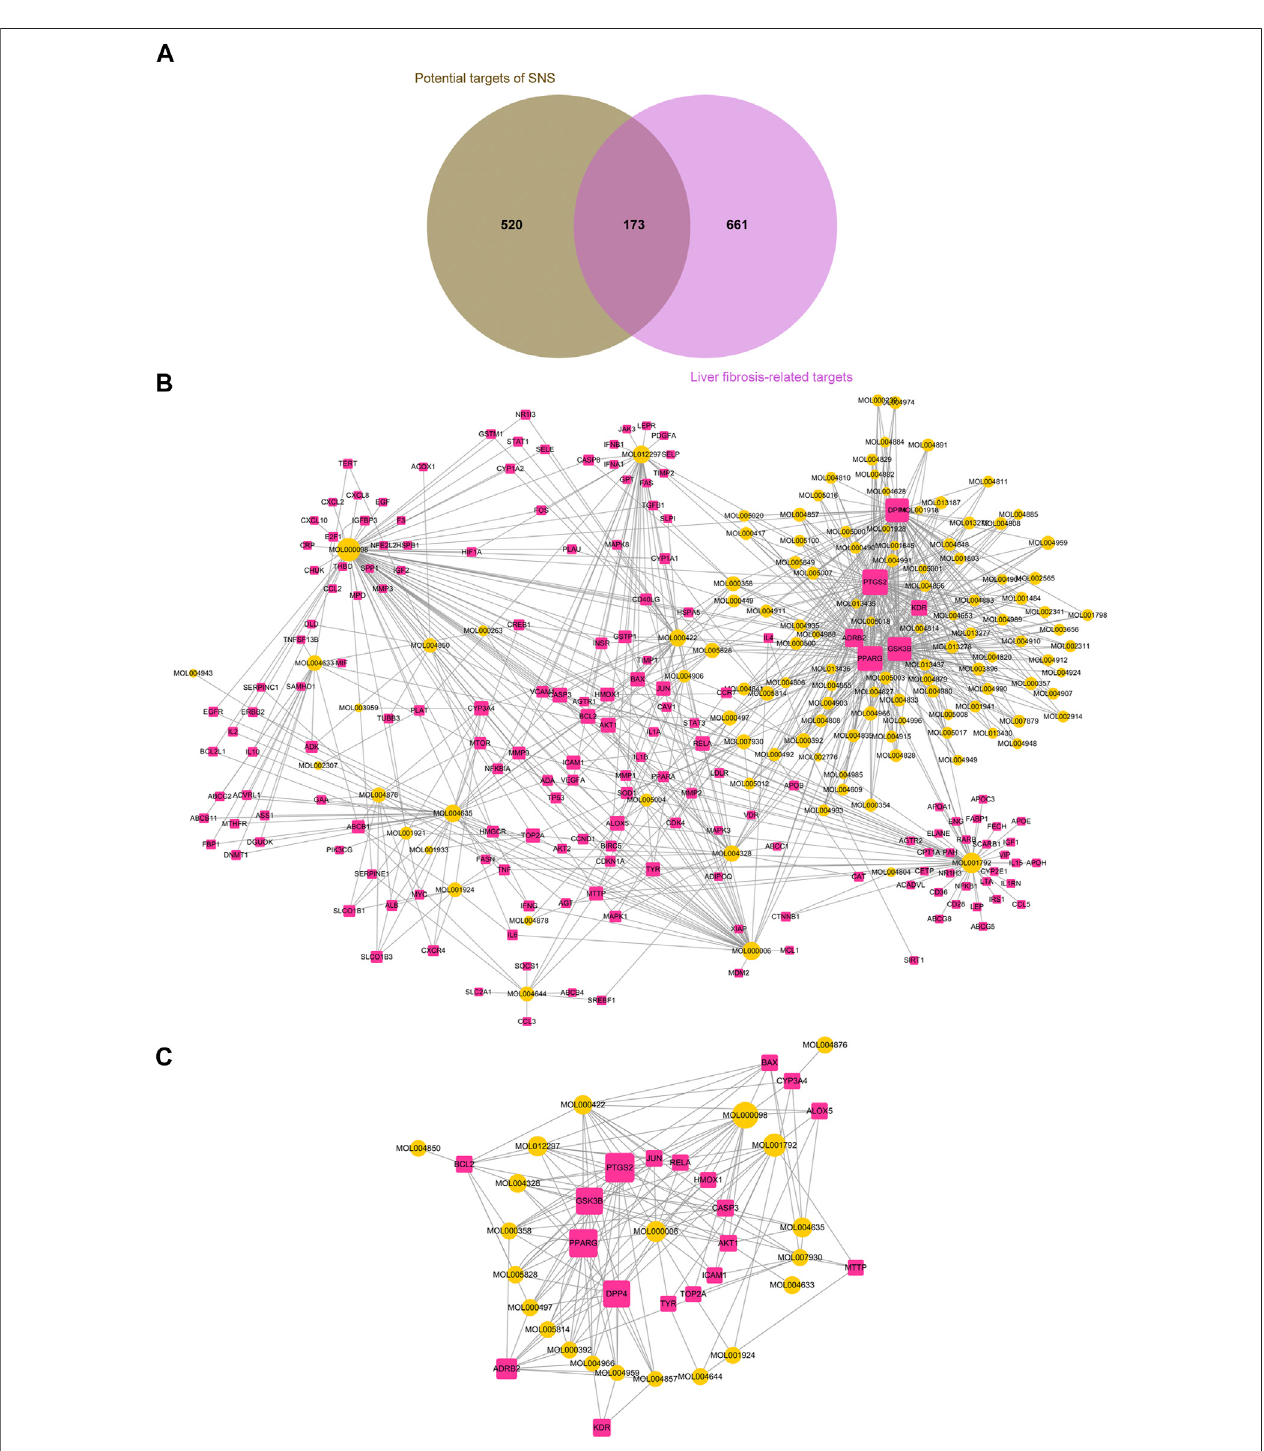
FIGURE 3 | Excavation of the core pharmacodynamic components and targets of SNS with activity against liver fi brosis. (A) Venn diagram showing that SNS shares 173 potential targets with known pathological targets of liver fi brosis. (B) Candidate active ingredient-target network of SNS. (C) Core active ingredient-target network of SNS.